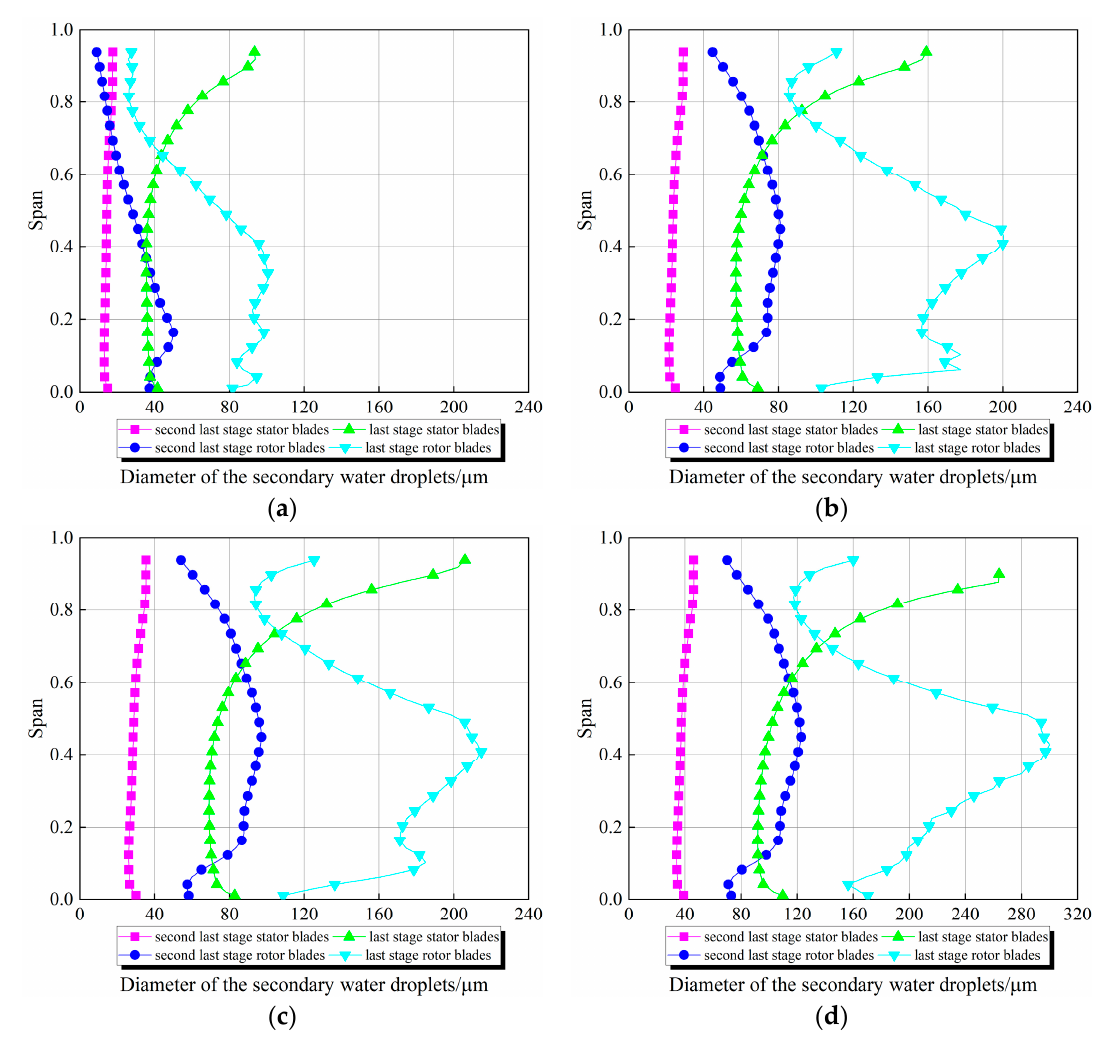
Figure 7. Diameter distribution of coarse water droplets along the blade height under different working conditions. ( a – d ), respectively, represent 100%, 50%, 40%, and 30% THA. Based on the above analysis, the maximum diameter of the coarse water droplets occurs at the tip of the last ‐ stage stator blade and at 40% of the blade height of the rotor blade, which indicates that the water droplet resistance loss is the largest at these two